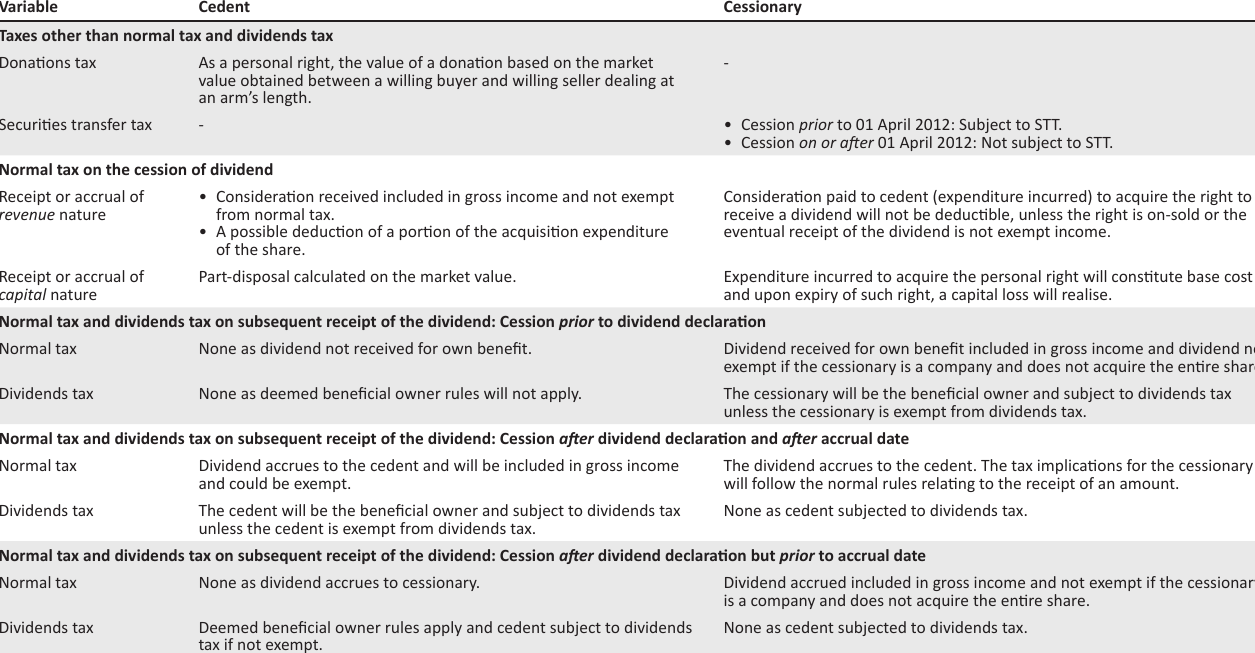
TABLE 2: Tax implications of a cession of the right to receive of a